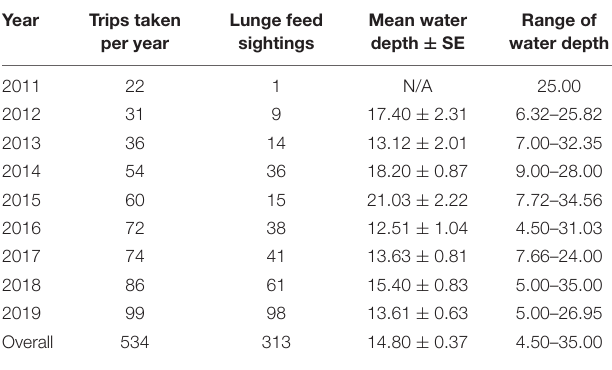
TABLE 2 | Summary of lunge feeding events recorded by year showing the observations marked as lunge feeding, mean water depth for each year, and the range of water depth in